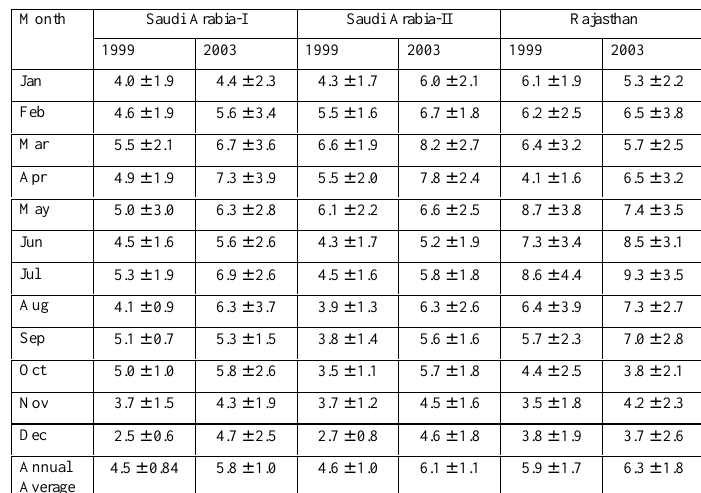
Table 3. Comparison of monthly mean IDDI (K). Table-3. Comparison of Monthly Mean IDDI